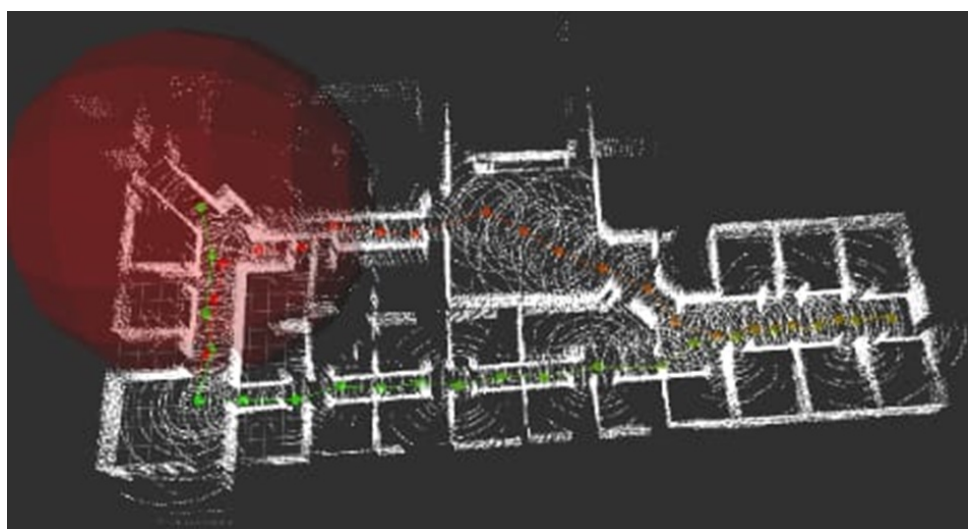
Figure 1. Map generated by Graph-based